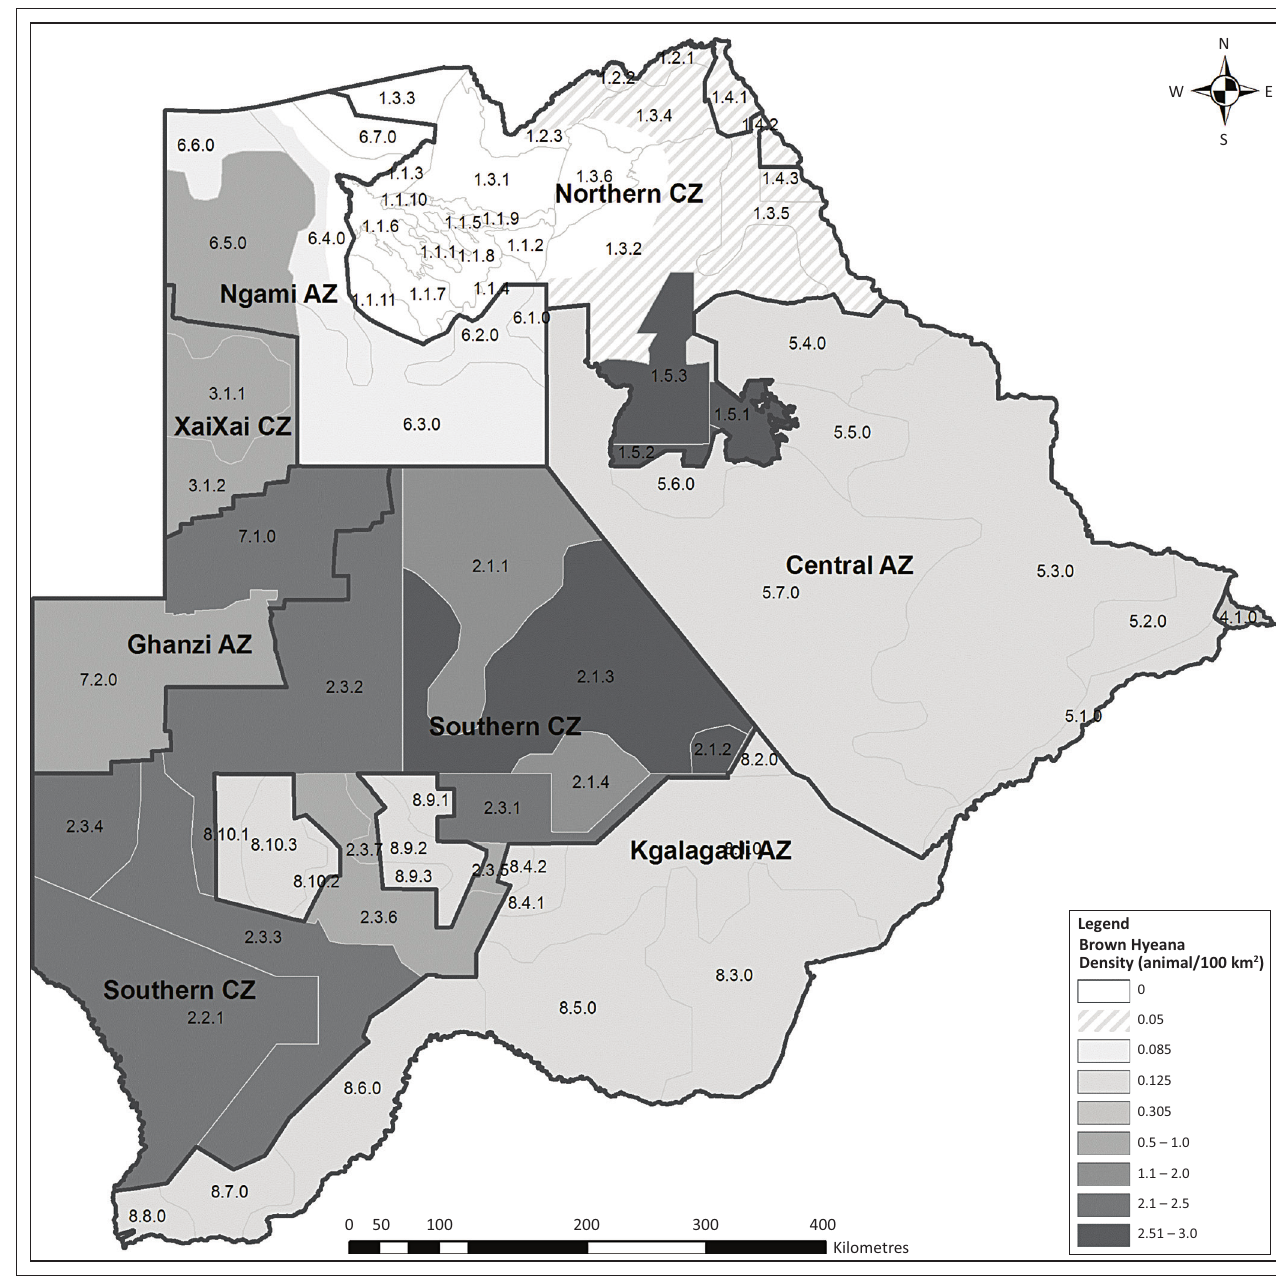
FIGURE 4: Estimated and assumed densities per stratum of brown hyaenas ( Parahyaena brunnea ) in Botswana based on surveys conducted between 2005 and